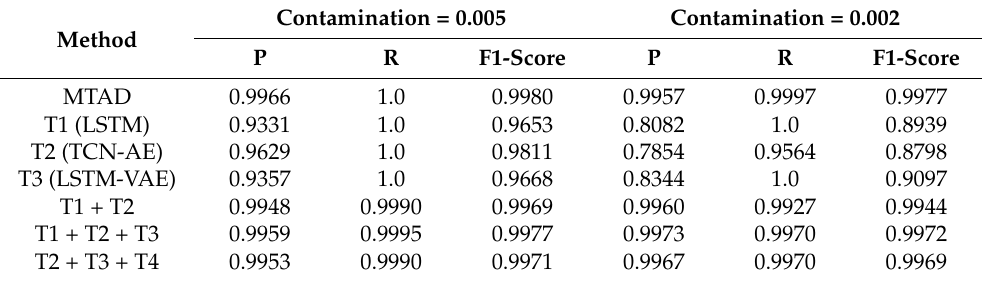
Table 4. Ablation study